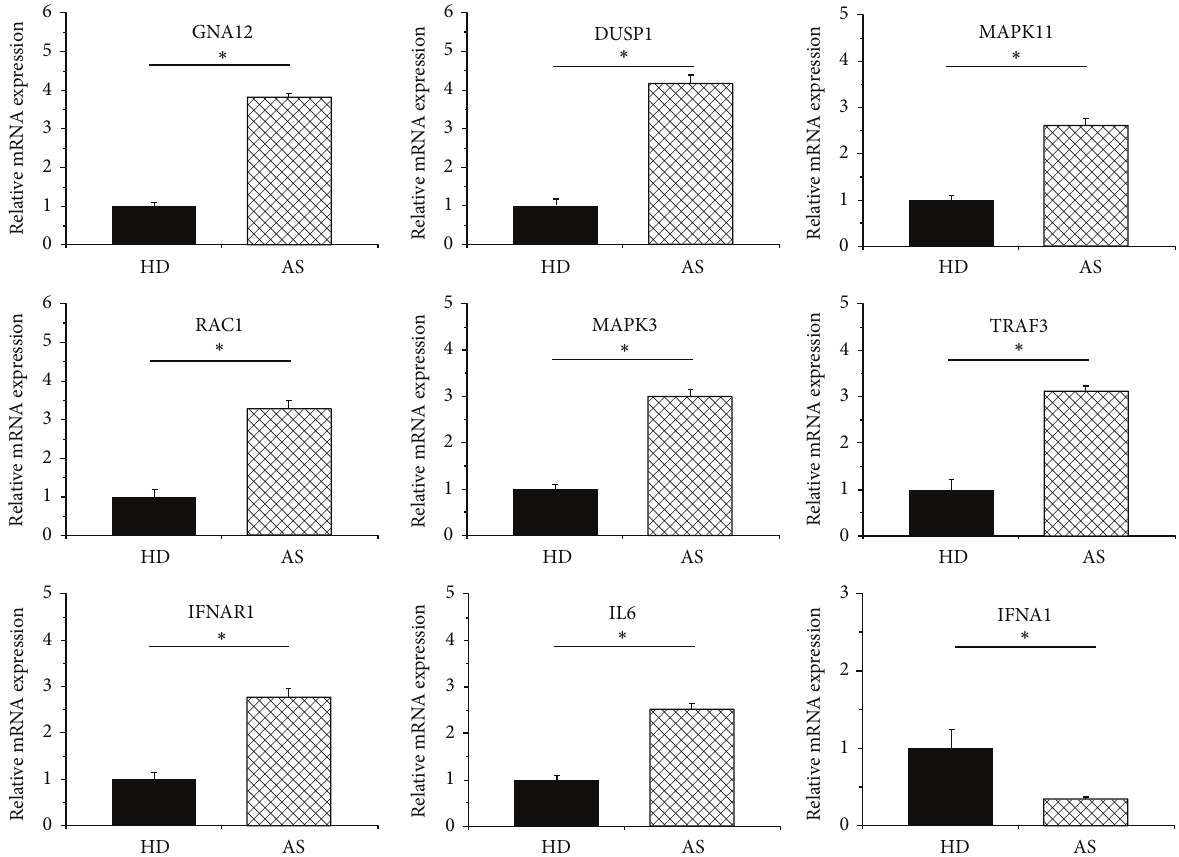
Figure 3: Verification of differentially expressed genes of MSCs in AS patients cultured in inflammatory environment. RNA was isolated from MSCs of HD ( 𝑛 = 5 ) and AS patients ( 𝑛 = 5 ) after MSCs were cultured in inflammatory environment mimicked by TNF- 𝛼 (10ng/mL) and IFN- 𝛾 (10ng/mL). Comparison of the levels of differentially expressed genes in MSCs from both groups was based on quantitative real-time polymerase chain reaction (qRT-PCR). Beta-actin was used as an internal control. The results showed that when grown in inflammatory culture medium, 9 of 22 differentially expressed genes from whole genomic expression analysis in AS patients were truly differentially expressed. These genes include GNA12, DUSP1, MAPK11, RAC1, MAPK3, TRAF3, IFNAR1, IL6, and IFNA1. The symbol “ ∗ ” represents 𝑃 < 0.05